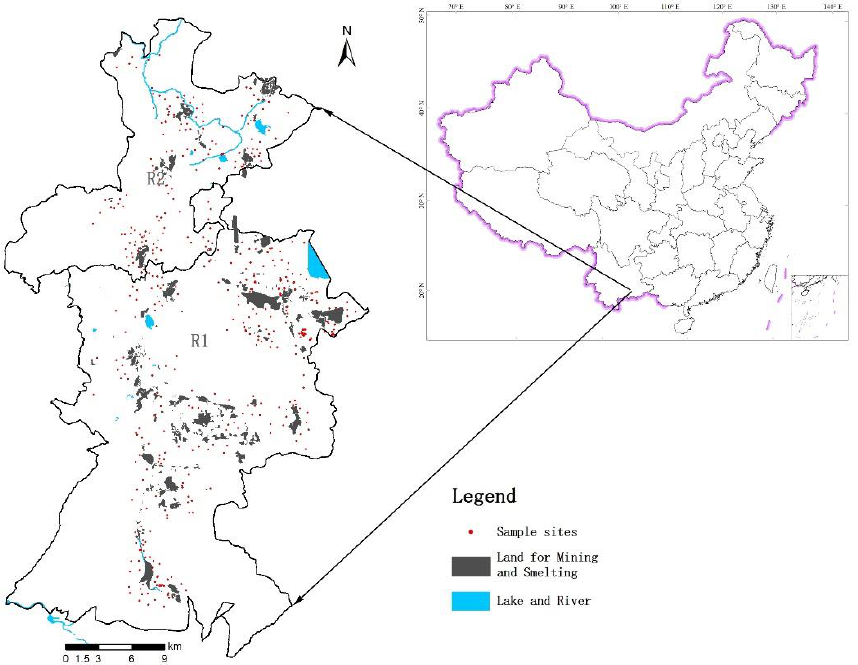
Figure 1. Land used for mining and smelting and the sampling sites in the study area.